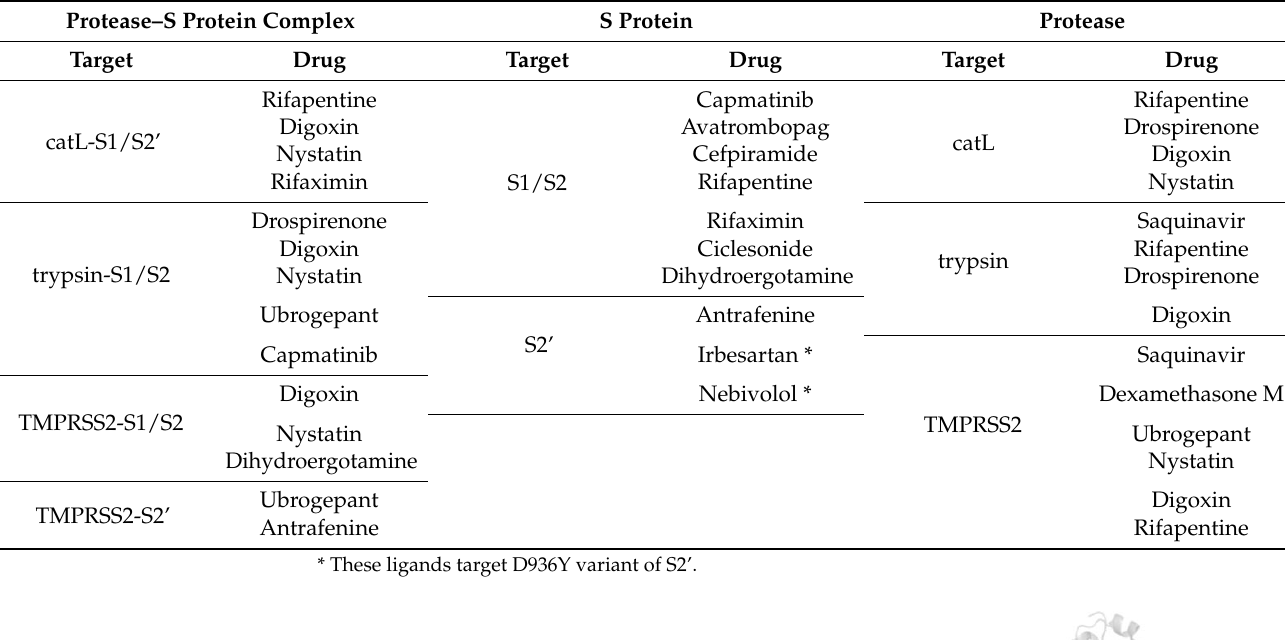
Table 2. The ligands and their targets obtained by MD simulations and ∆ G calculations.